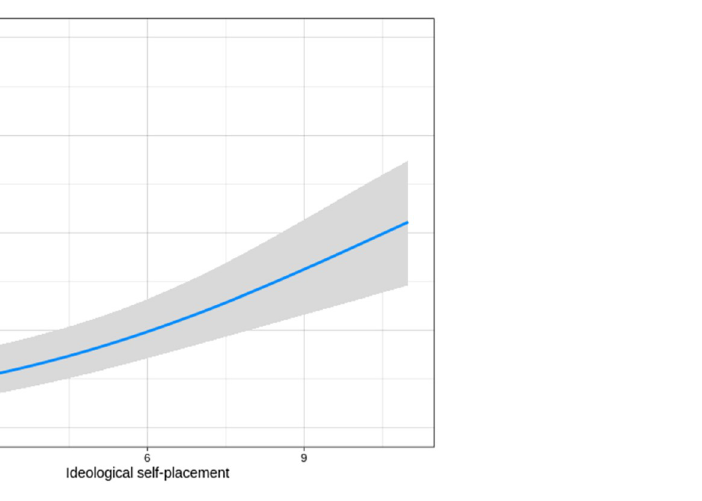
Fig 2. Likelihood of selective exposure by political